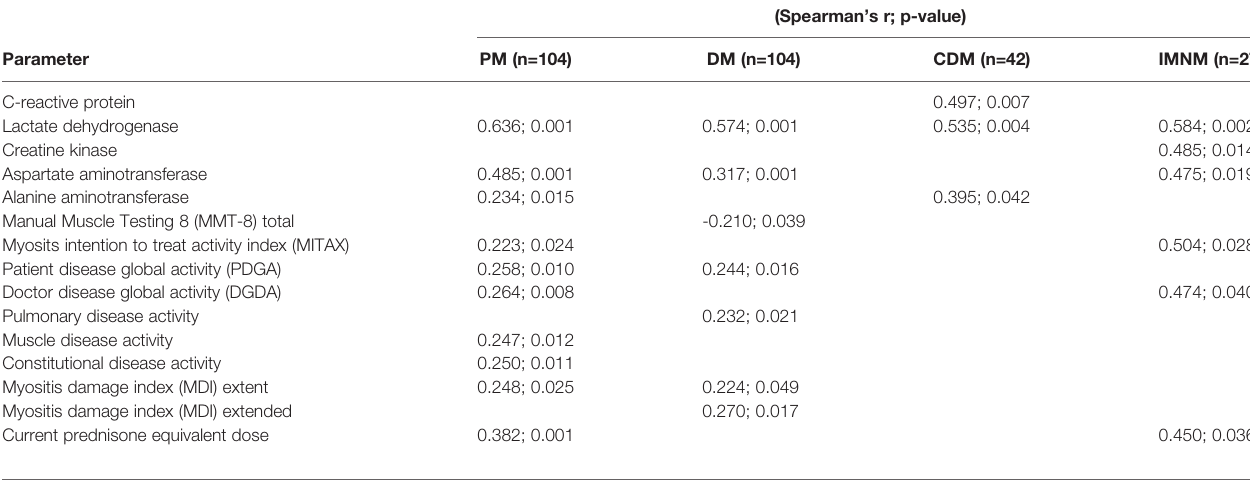
TABLE 4 | Signi fi cant disease-related predictors of Hsp90 plasma levels in patients with individual subsets of IIM based on bivariate correlations.